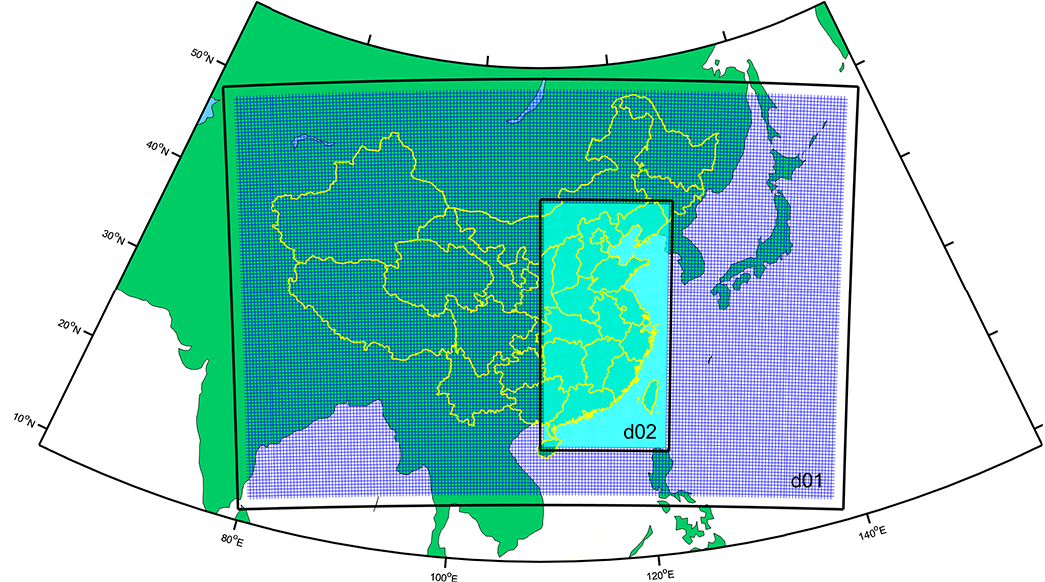
Figure 2. The two nested modelling domains, denoted as d01 and d02. The black boxes indicate the WRF modelling domains, and the nested areas are the CMAQ modelling